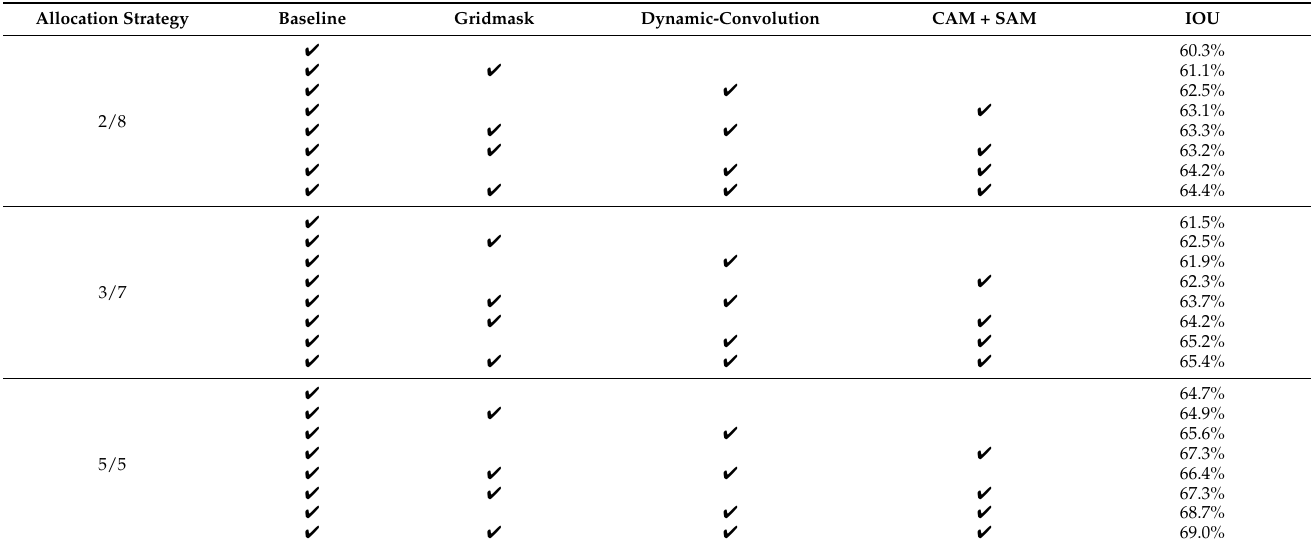
Table 3. Results of ablation study on the Flame dataset. ( (cid:52) denotes the module is included in the method.)